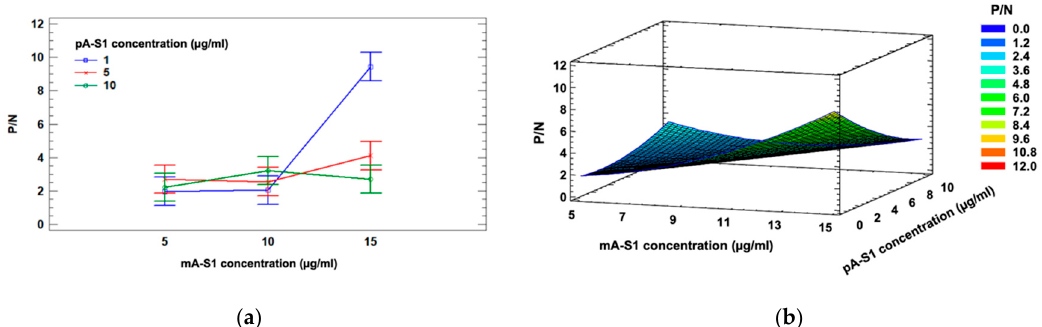
Figure 4. ANOVA interaction plot ( a ) and response surface ( b ) showing the effect of pA-S1 and mA- S1 on the P / N